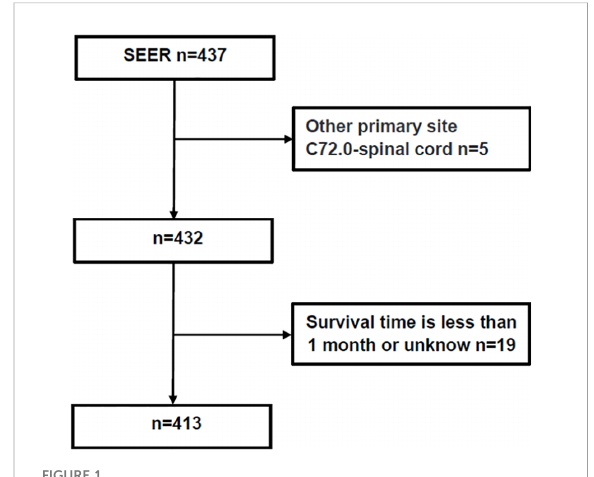
FIGURE 1 The method of obtaining data from the SEER